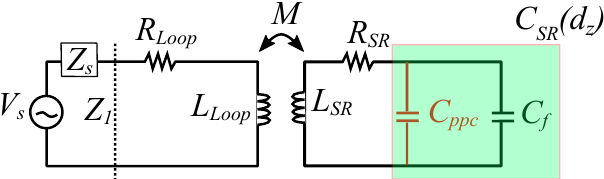
Figure 13. Proposed improved equivalent circuit model, taking into account the additional capacitive coupling ( C ppc